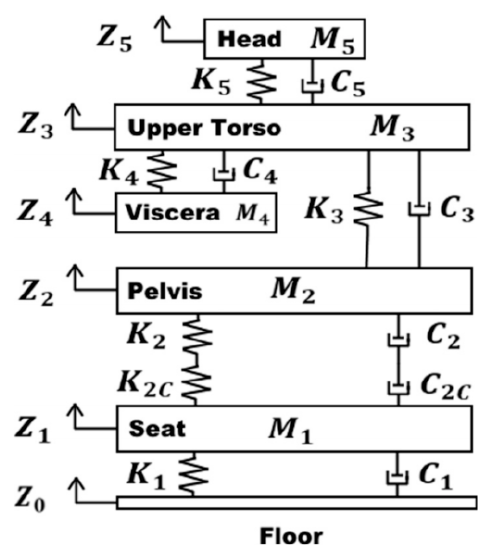
Figure 28. A 5-DOF seat–occupant model [68].